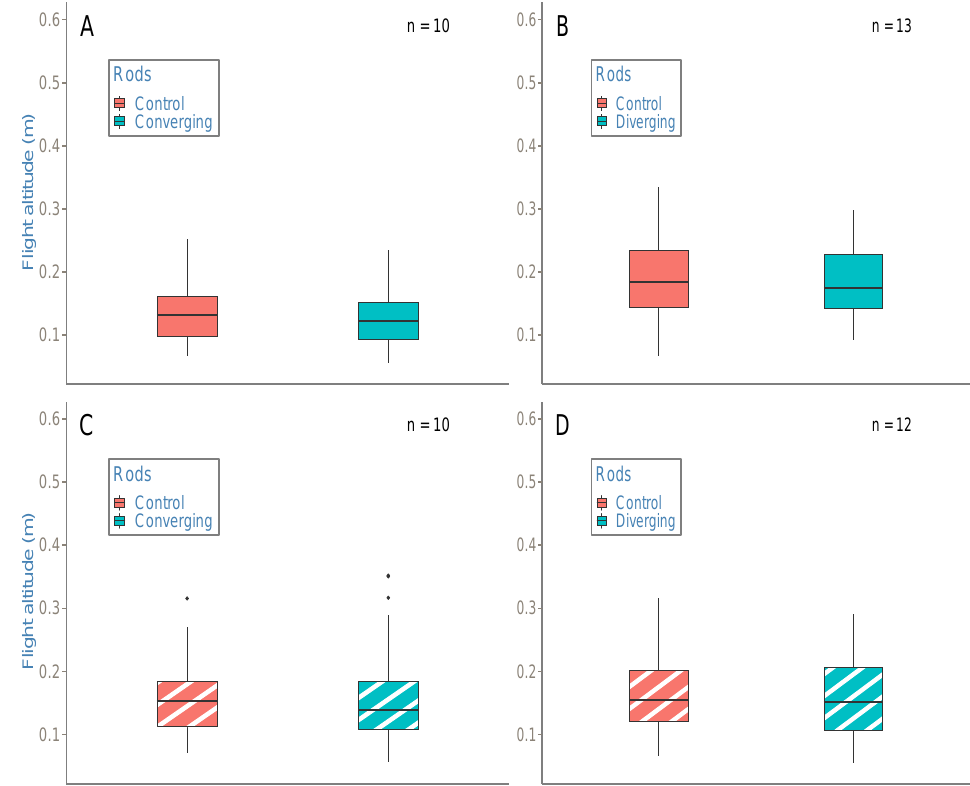
Figure 7. Altitude of bees subject to a change in splay angle value. The four experimental conditions were ( A )—converging condition above white ground; ( B )—diverging condition above white ground; ( C )—converging condition above striped ground; ( D )—diverging condition above striped ground, compared to their respective control conditions (parallel or narrow). The rods were set as converging or diverging before bees entered the tunnel. In each condition, bees maintained the same altitude for the whole of their flight through the tunnel (Figure 7; for all comparisons p > 0.01). Outliers are represented by solid circles. Randomly selected flights were analyzed in each condition, respecting a ground-following criterion (see Section 2.2.4). Raw trajectories from the trials are visible in Figure S3. In static converging and diverging conditions (Figure 7A,B), splay angle was ma- nipulated between flights. The results revealed that the bees undergoing splay angle manipulations passed through the tunnel without any change in altitude, either in con- verging or in diverging conditions, above white ground (Figure 7A,B; for all comparisons p >